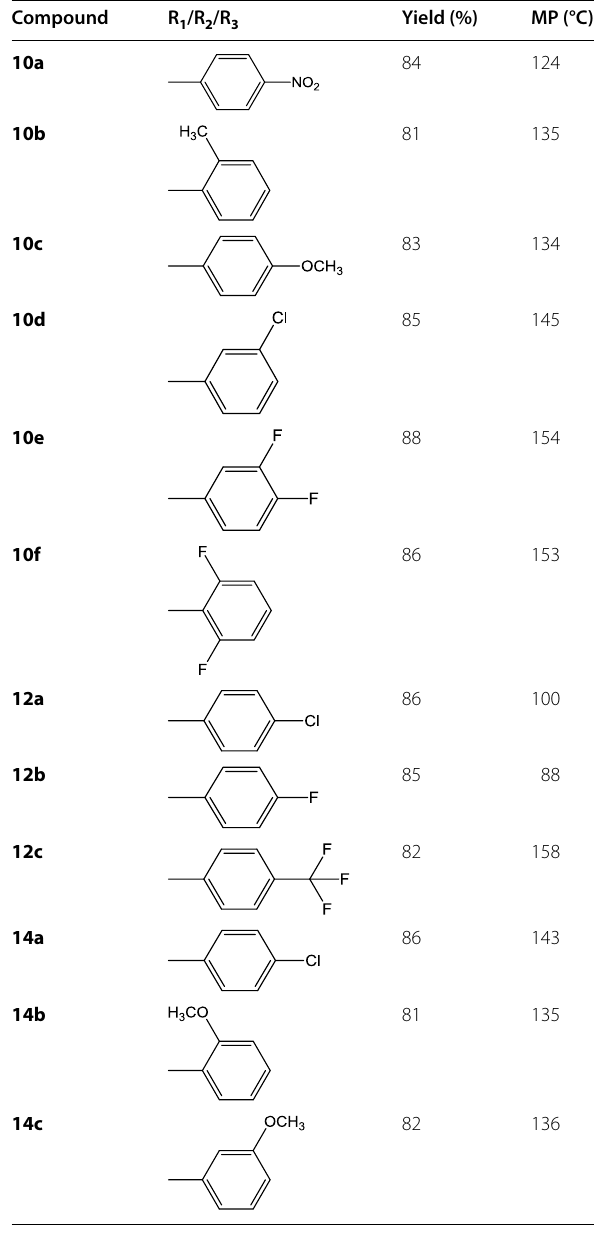
Table 1 Chemical structure, yield and melting point of the synthesized compounds